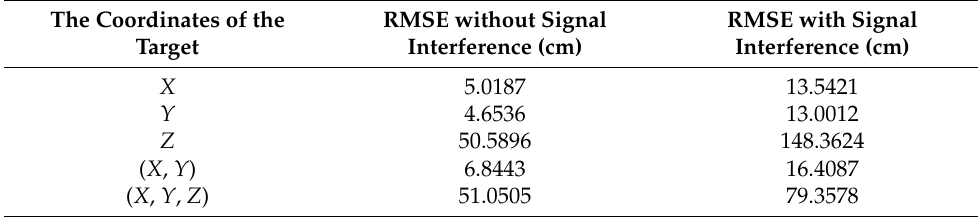
Figure 10. The comparison of the true value and estimated value of the target coordinates with signal interference. Table 3. The RMSE of preliminary estimation of the target coordinates with and without signal interference.